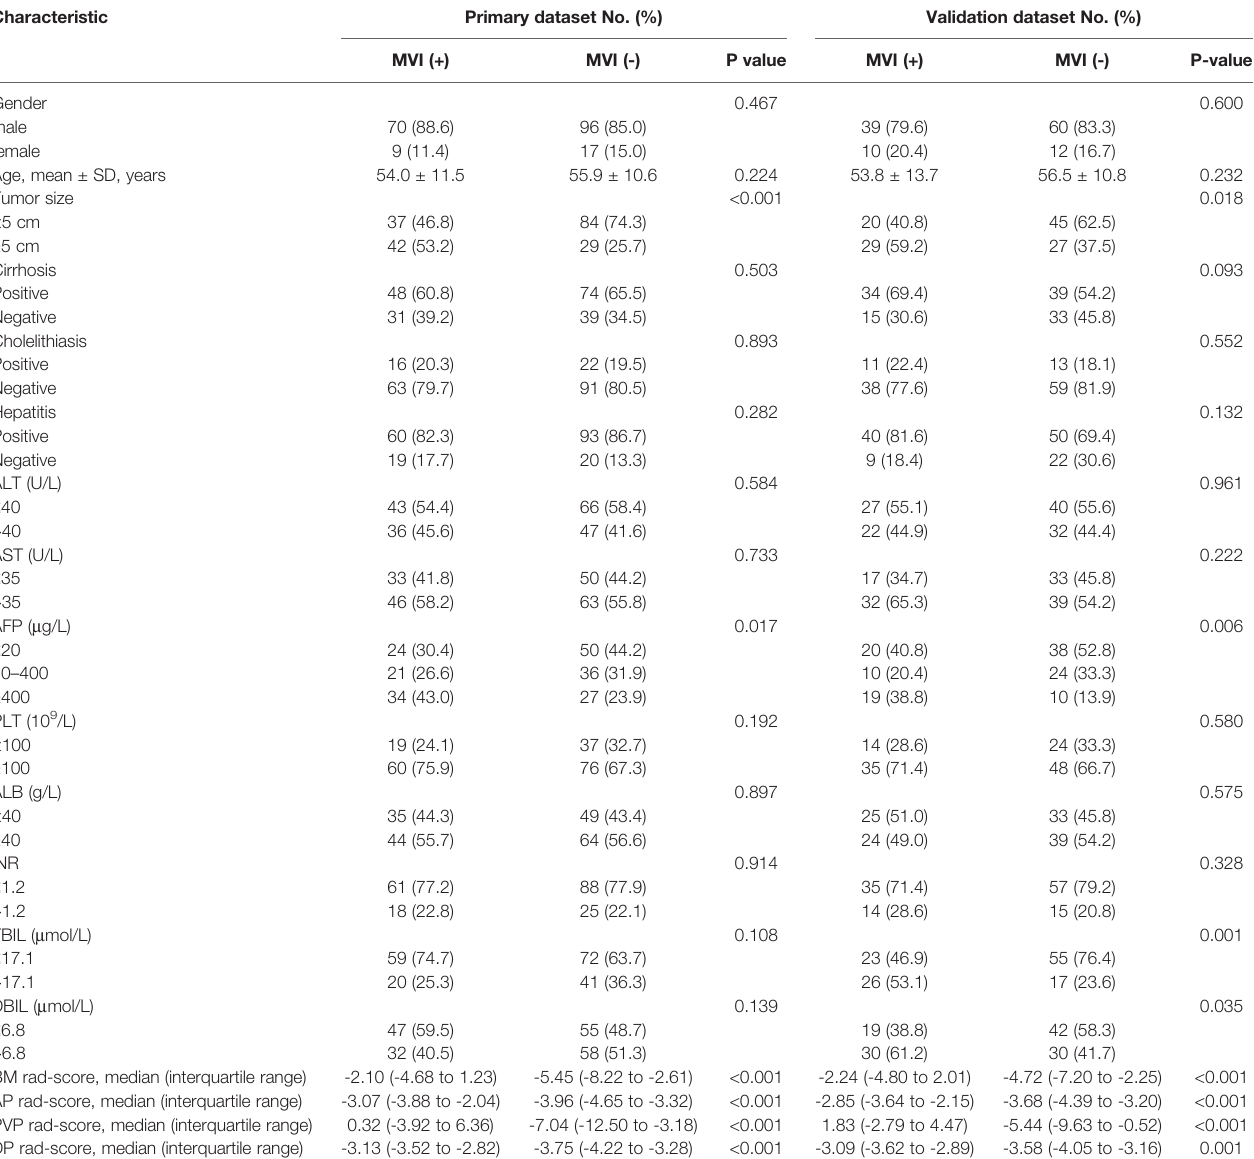
TABLE 2 | Preoperative predictors for MVI in the primary and the validation datasets. Characteristic Primary dataset No.